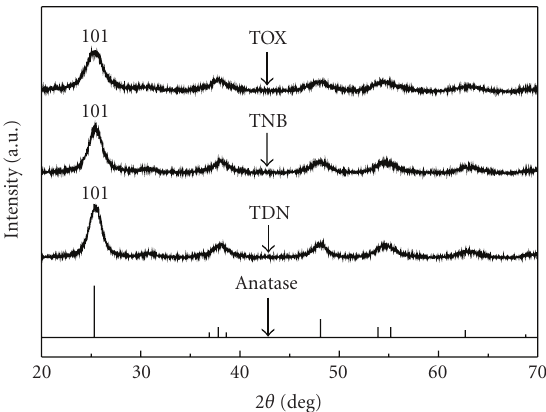
Figure 1: XRD patterns of samples, TOX, TDN, and TNB. Sam- ple TOX was undoped TiO 2 , sample TDN was N-doped TiO 2 , and sample TNB was N, Br-codoped TiO 2 .